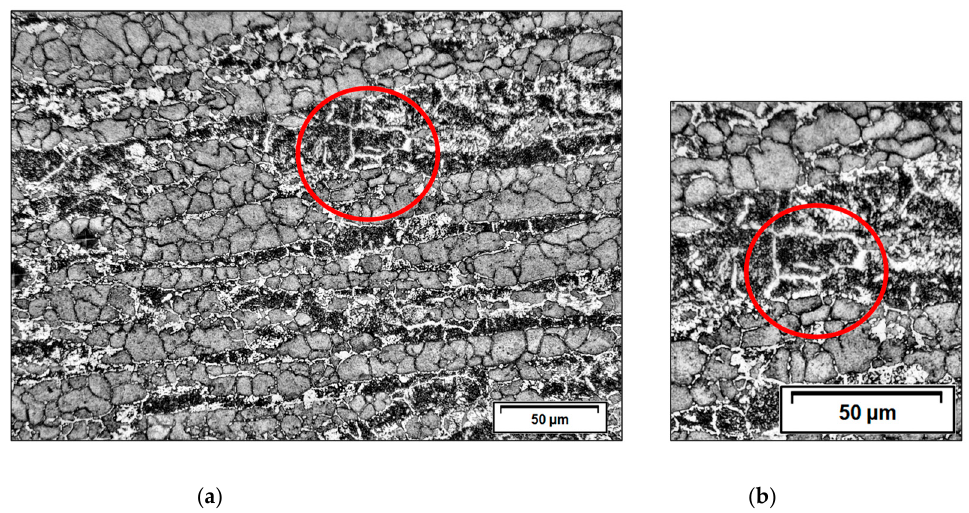
Figure 11. ( a ) Micrograph of the sample treated at 800 °C for 108,000 s (30 h), presenting the region of interest for reconstruction within the red circle; ( b ) the boundary that will be reconstructed, shown in detail.